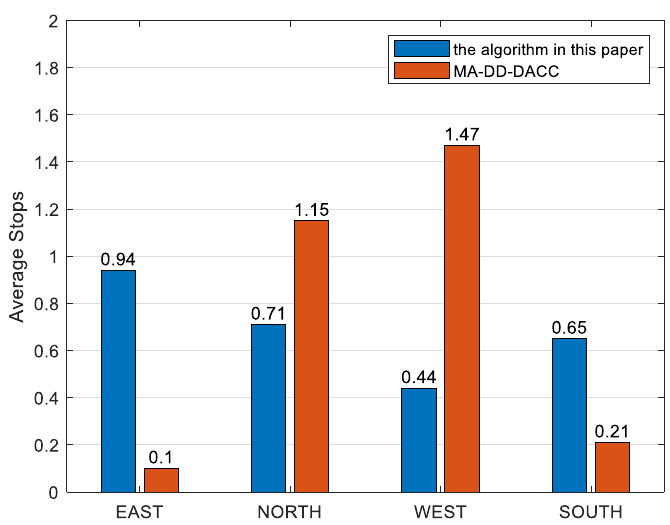
Figure 4. The average delay of each vehicle.